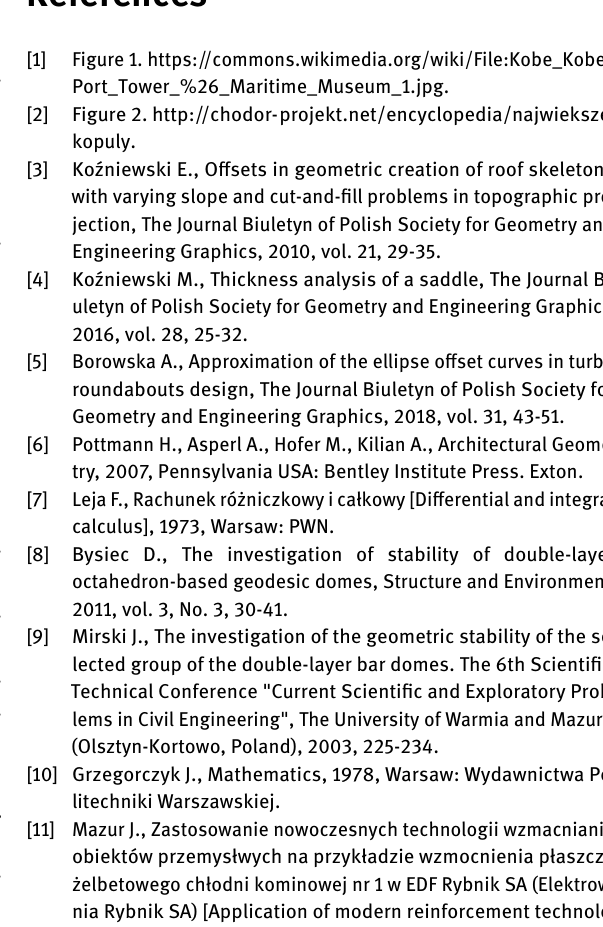
Figure 1. https://commons.wikimedia.org/wiki/File:Kobe_Kobe_ [2] Figure 2. http://chodor-projekt.net/encyclopedia/najwieksze-